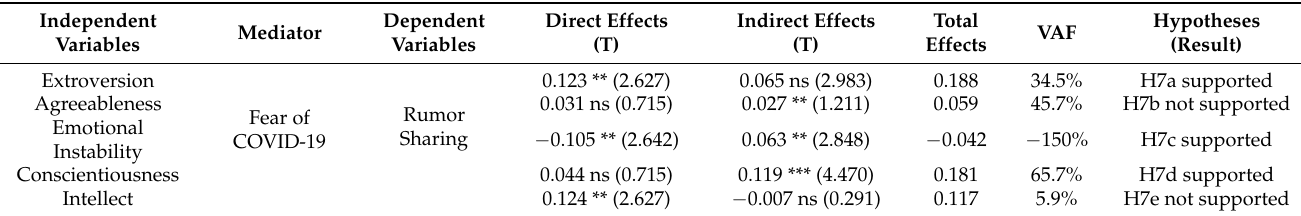
Table 5. Results of the mediation analysis.